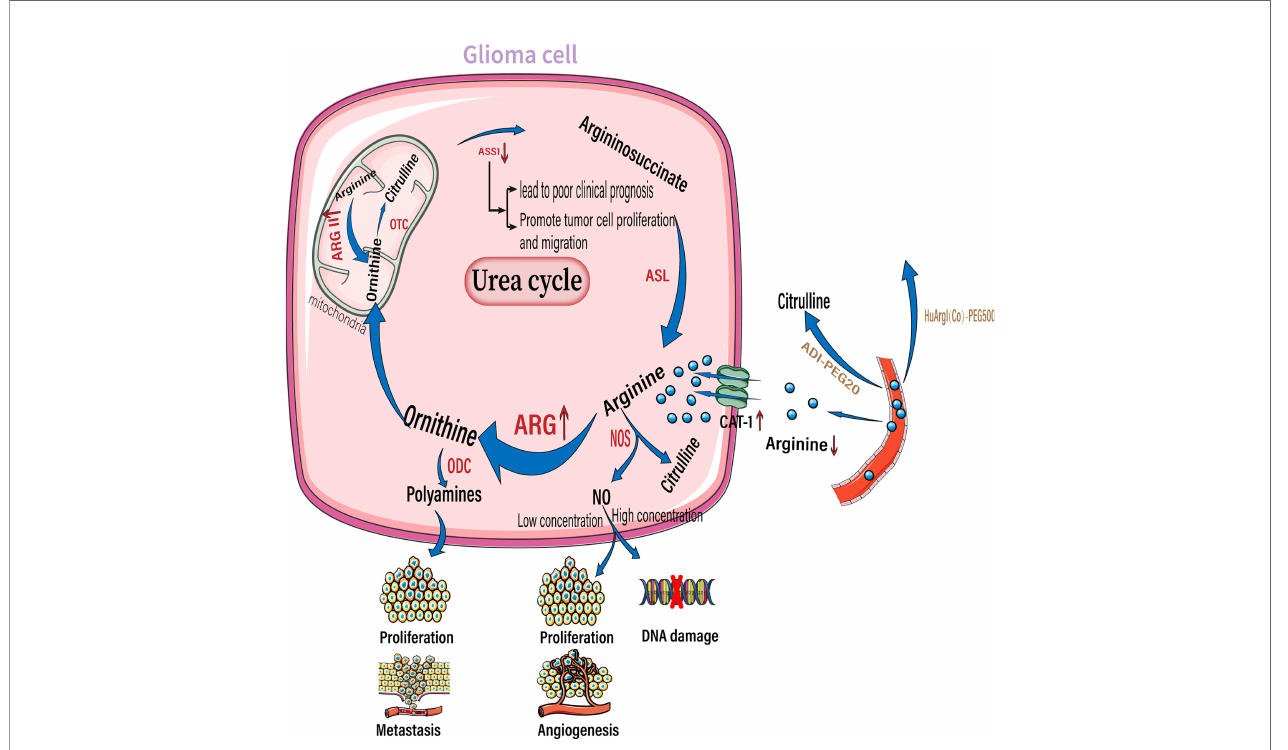
FIGURE 3 | Arginine reprogramming in glioma cells. In glioma cells, ASS1 expression was downregulated while CAT-1 and arginase were upregulated. The upregulated arginase is mainly arginase II located in the mitochondria. The use of ADI-PEG20 and HuArgI(CO)-PEG5000 to break down Circulating arginine results in a signi fi cant decrease in arginine concentration in the extracellular environment. Among the downstream metabolites of arginine, polyamines can promote tumor proliferation and metastasis, low concentrations of NO promote tumor proliferation and angiogenesis, and high concentrations of NO cause DNA damage. NO, nitric oxide; NOS, nitric oxide synthase; ARG, arginase; ODC, ornithine decarboxylase; OTC, ornithine transcarbamylase. ASS1,, argininosuccinate synthase; ASL, argininosuccinate lyase.;ADI-PEG20, pegylated arginine deaminase; HuArgI(CO)-PEG5000 ,Pegylated recombinant human arginase